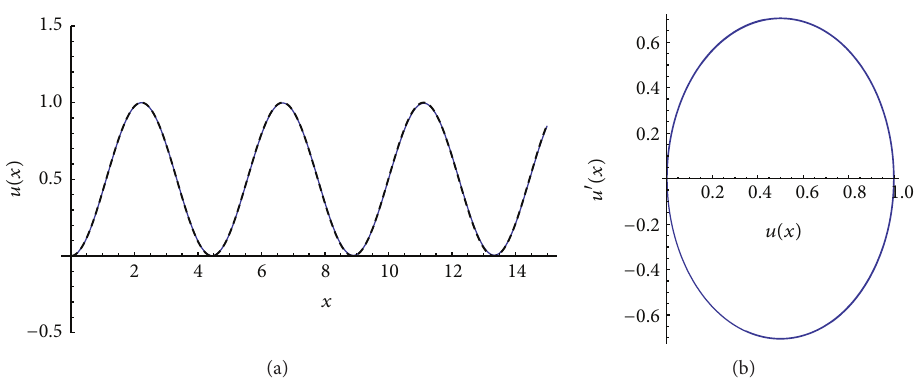
Figure 1: (a) Plots of displacement of 𝑢 versus time: solid line the multistep RKHS method and dashed line exact solution. (b) Phase plane diagram of Example 1.